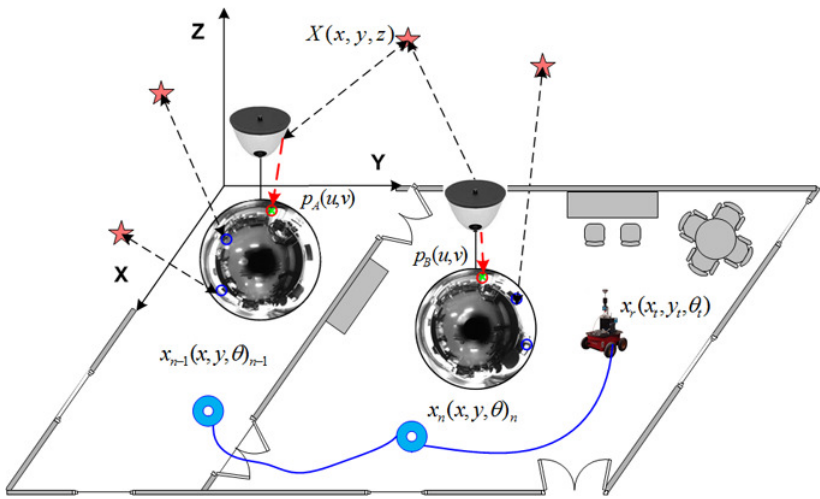
Figure 8. Dual 2D-3D map representation. Visual information is encoded on the 2D image plane by feature points in pixels ( u , v ) , which are compressed on each view, x n . These views are representative for specific areas of the environment with different visual appearance. The re-estimation of views implies a simpler re-estimation of larger number of 3D landmarks at once. The position where views were initiated in the map is indicated by circles. An example of real images is also